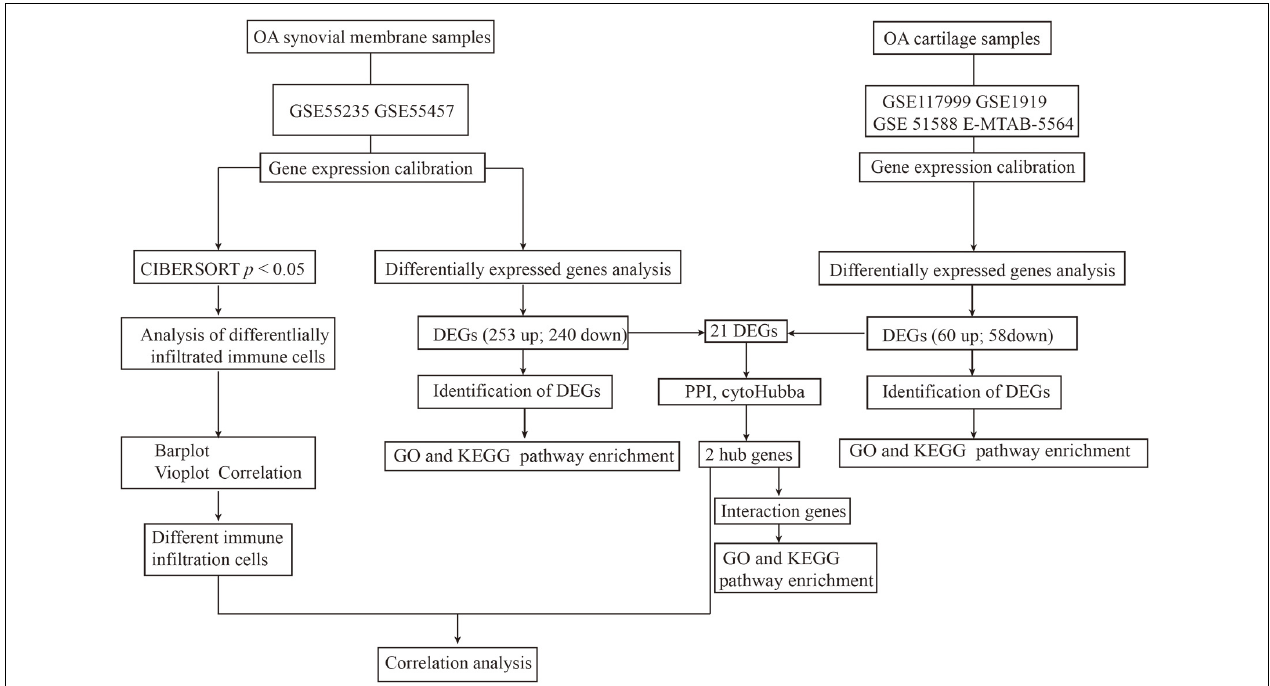
FIGURE 1 | Workflow of the entire